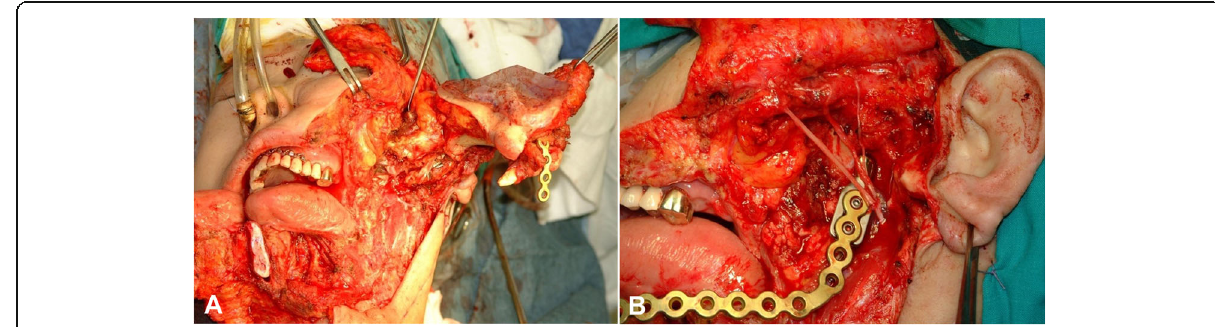
Fig. 5 Surgical images showing the zygomatico-transmandibular approach to the lateral skull base ( a ) and its repositioned state, with reconstruction plate and sural nerve graft to the facial nerve trunk ( b